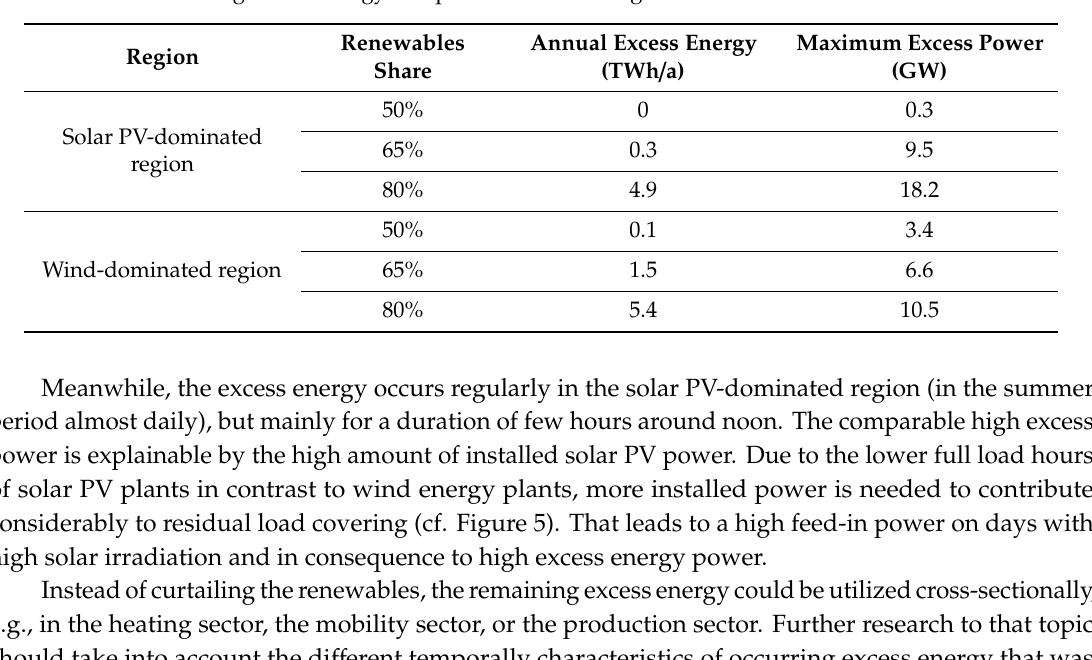
Table 3. Remaining excess energy and power after covering of residual load in CLASSIC scenarios. Renewables Region Share